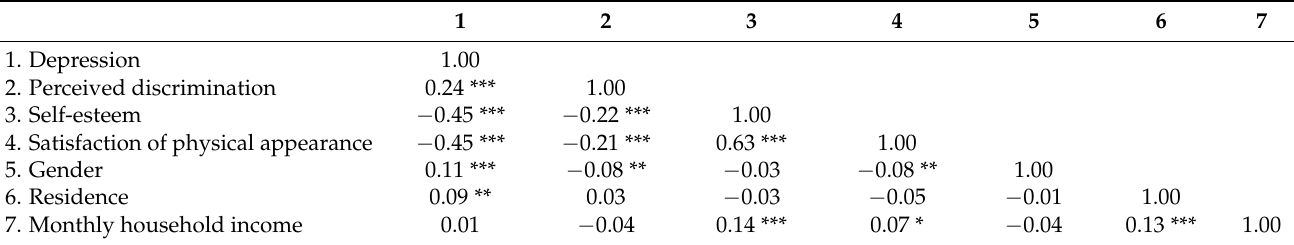
Table 2. Correlations matrix of the study